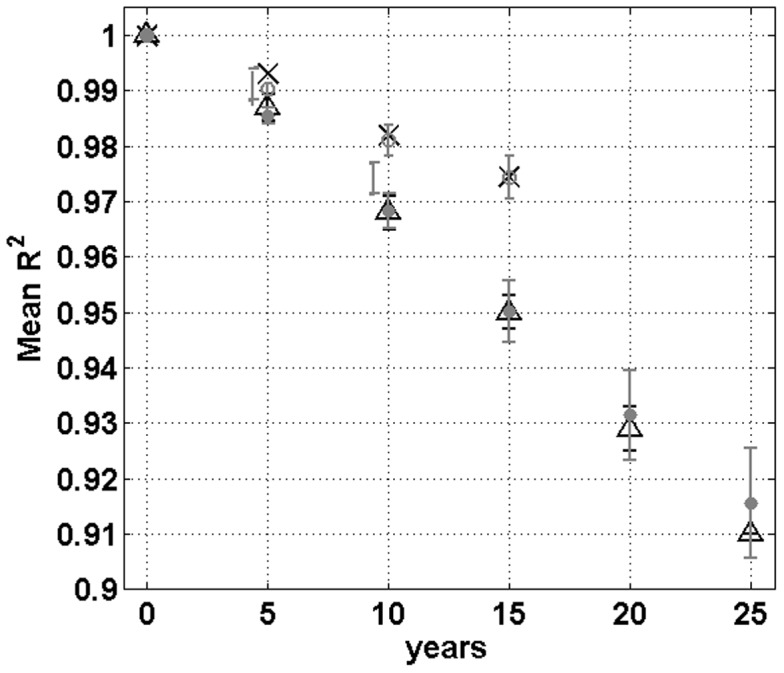
Observed and predicted compositional changes in tree communities between censuses at Pasoh and Barro Colorado forests.Compositional changes are measured by the coefficient of determination R
2 of the regression of the log-transformed, time-lagged population abundance of all species between censuses for all individuals with dbh≥1 cm and species with two or more individuals in first census of each forest [25], [26]. At a time lag of zero, no change in community composition can yet have occurred, and thus R
2 is by definition equal to unity. As time elapses between censuses, the progressive compositional changes are reflected by the decay in R
2: empirical results for Barro Colorado (triangles) and Pasoh (crosses), and predicted values, corresponding to averages over 100 simulations with error bars equal to one standard deviation for the best parameters estimates for each forest. The model predicts a nearly perfectly linear decay in average values of R
2 that is indistinguishable from the prediction from NTB.